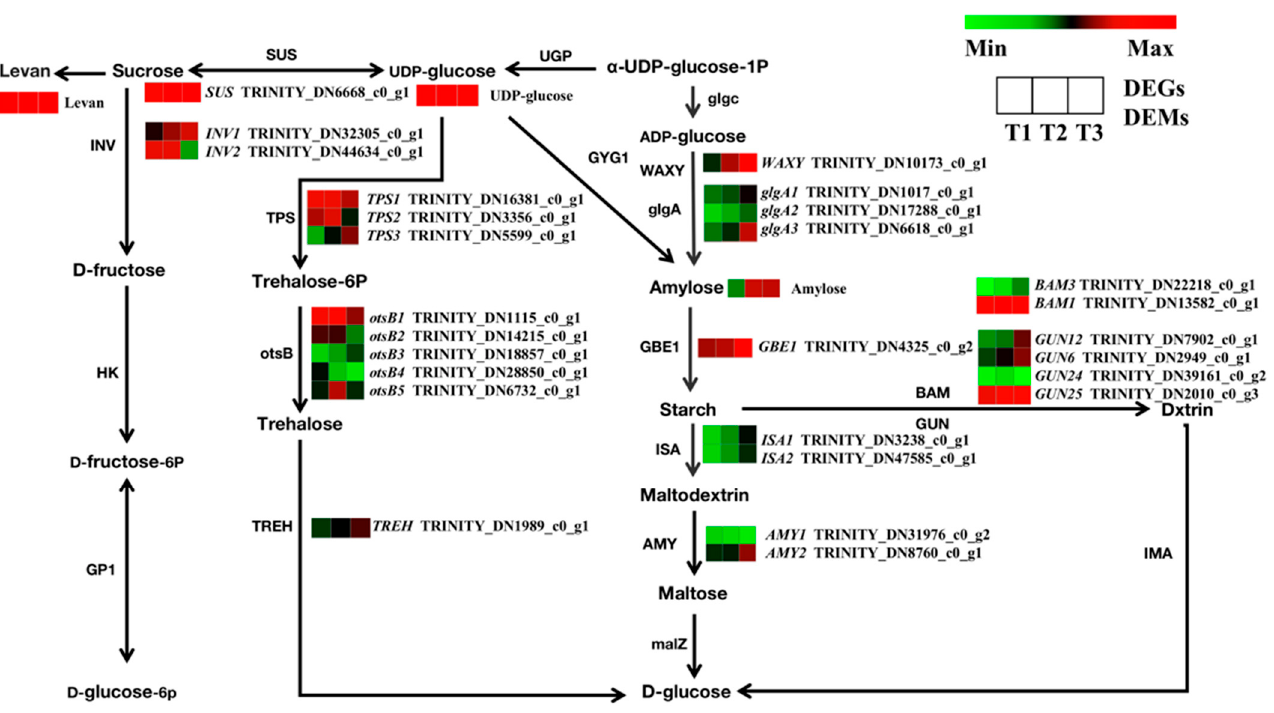
Figure 10. Regulatory network of starch and sucrose metabolism in three different root samples. The color scale from green to red for the heatmap represents downregulated and upregulated expression. SUS, sucrose synthase; INV, β -furan glycosidase; TPS, trehalose 6-phosphate synthase/phosphatase; TREH, α , α -trehalase; glgA, glycogen synthase; GBE1, 1,4- α -glucan branching enzyme; ISA, isoamylase; AMY, α -amylase.